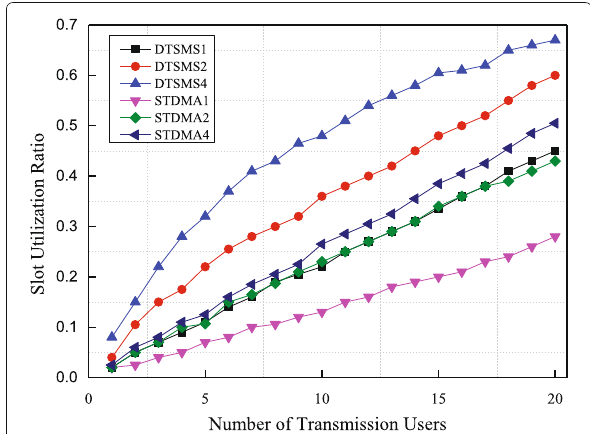
Fig. 13 Network throughput when each transmitter has different transmission chances